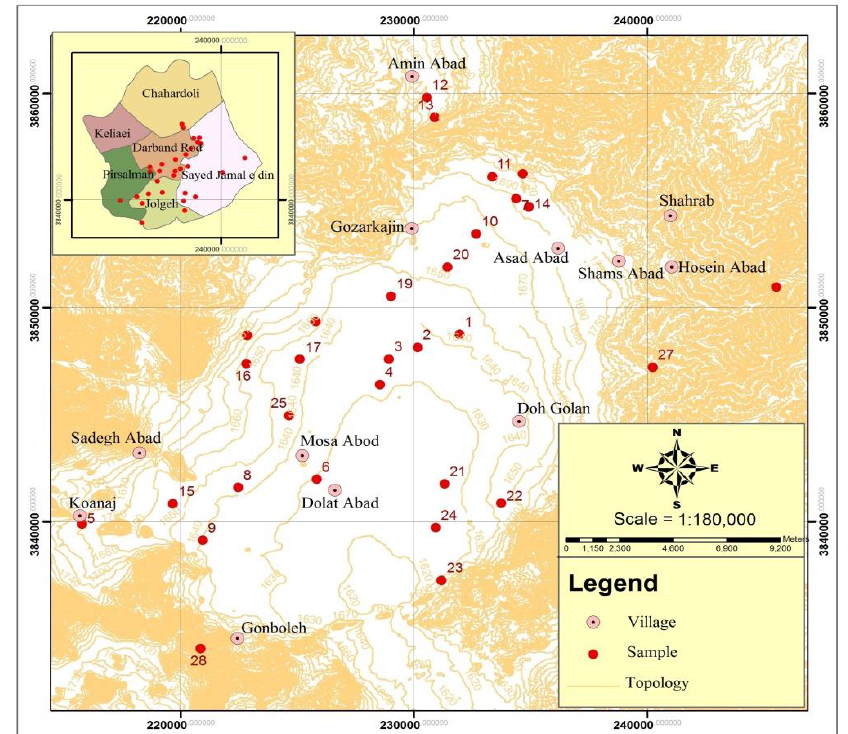
Figure 1. Map of sampling stations